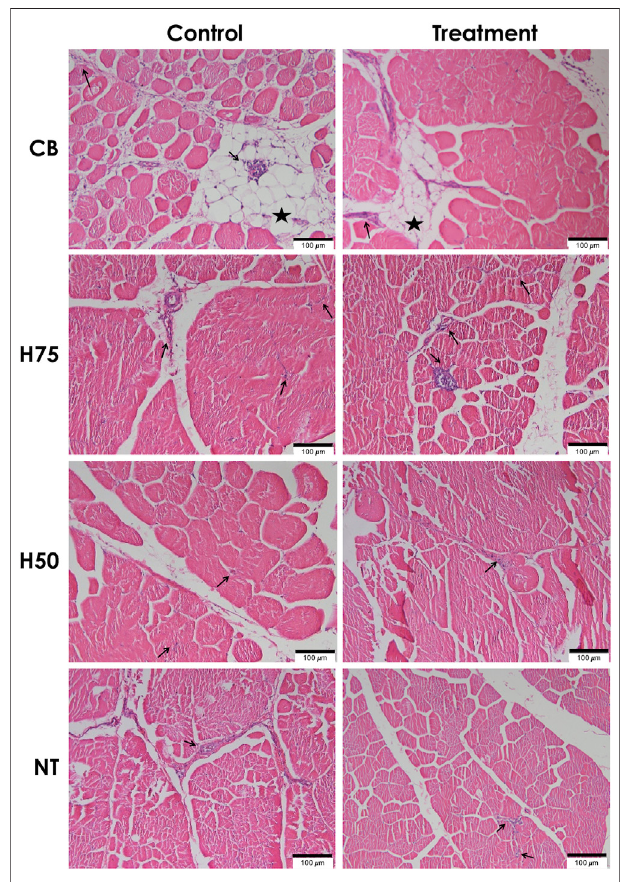
FIGURE 2 | Histological fi ndings for hematoxylin and eosin (H&E) – stained pectoralis major muscle sections. Examples of microscopic images (scale bar of 100 μ m) of H&E – stained pectoralis major muscles collected from different chicken breeds. The birds were reared at a constant temperature (control, 26 ° C) or received heat challenge (treatment, 35 ° C, 6 h daily) for 20 days before reaching their market ages. CB: commercial broilers; H75: crossbreeds, 75% broiler background and 25% Thainativebackground;H50:crossbreeds,50%broilerbackgroundand50% Thai native background; NT: Thai native chickens. Arrows and stars indicate accumulation of in fl ammatory cells and adipose tissue, respectively.